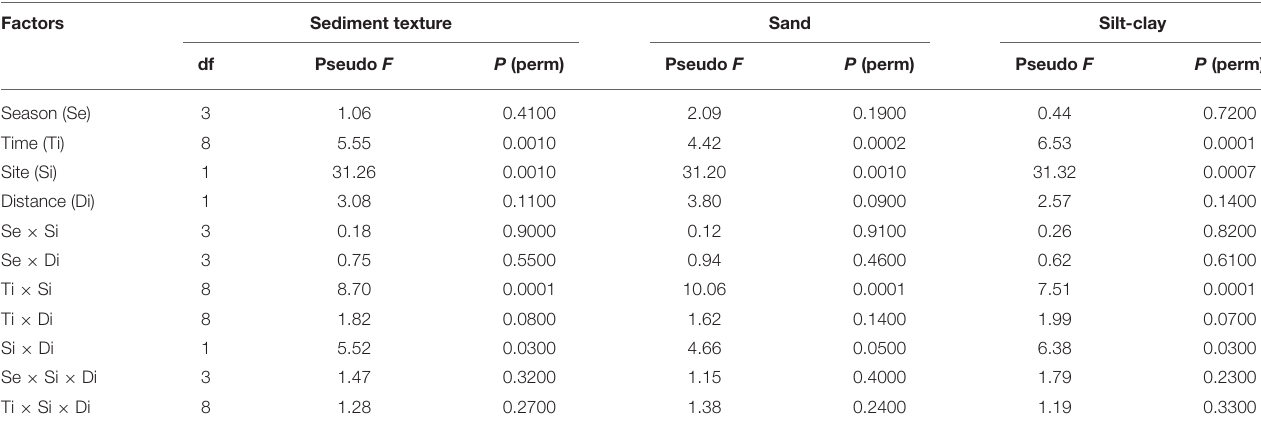
and a maximum of 85%. However, there was no significant difference for sediment distribution in PSO across seasons ( Figure 5D ). Documented mean wave height for November to December sampling period was of 1.22 m, dominant wave period of 8.78 s, with 61% of days overpassing a wave height of 1 m, and 19% of days the waves were higher than 1.5 m ( Figures 6A,B